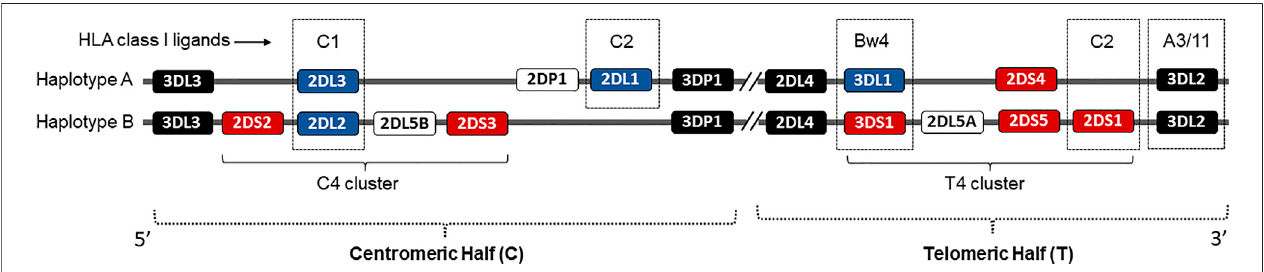
FIGURE 1 | Schematic representation of the KIR genetic complex. Two common KIR haplotypes, A and B, carry contrasting numbers and types of KIR genes. Genes encoding KIR receptors for cognate HLA class I ligands are identi fi ed in dotted boxes. Genes encoding activating KIRs are shown in red boxes. The framework genes are shown in dark boxes. The centromeric and telomeric KIR halves and C4 and T4 gene clusters are